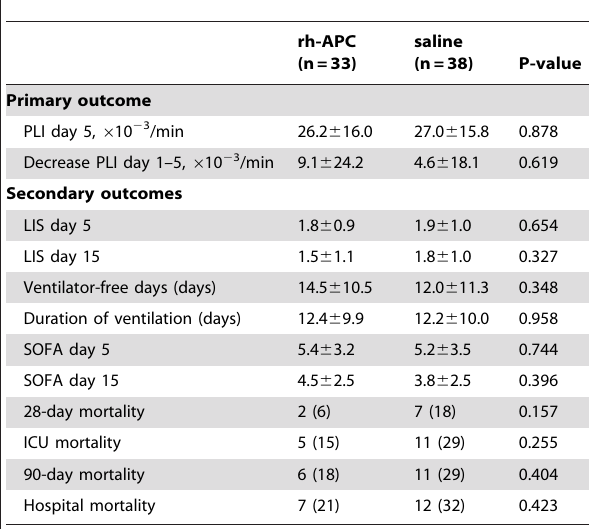
Table 3. Primary and secondary outcome